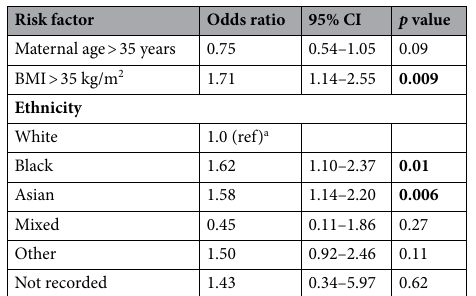
Table 3. Risk factors for a positive RT-PCR swab for SARS-CoV-2. Significant values are in bold. a For ethnicity, the modal group was used as a reference to calculate odds